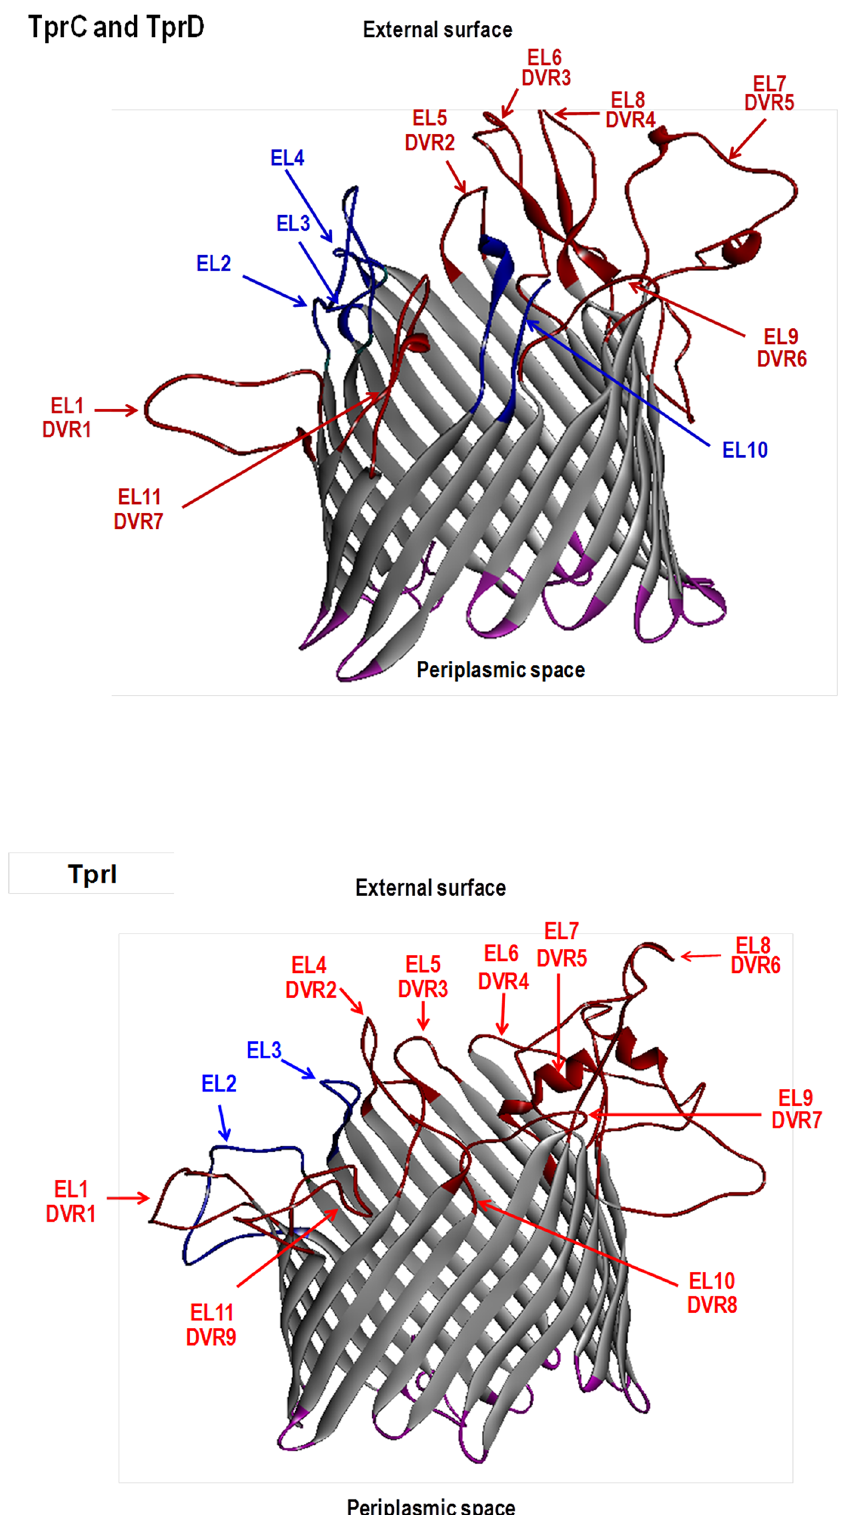
Figure 3. Structural models of TprC/D and TprI. Non-templated 3D models generated for the mature Nichols TprC/D and Nichols TprI peptides using the TMBpro algorithm [61] suggest a typical b -barrel structure. DVR,discrete variable regions. EL, external loops. Variable regions, DVR1–DVR7 for TprC/D and DVR1–DVR9 for TprI, as defined by protein sequence alignments (Figure S1 and S2) are indicated by red color (loops, font and arrows). Note that each DVR co-localizes with a predicted EL. Orientation of the structure was determined as specified by Randall et al [61]. Proposed conserved and variable surface exposed loops are highlighted in blue and red, respectively, and proposed periplasmic exposed regions of the proteins are in purple. doi:10.1371/journal.pntd.0002222.g003 PLOS Neglected Tropical Diseases | www.plosntds.org 6 May 2013 | Volume 7 | Issue 5 |